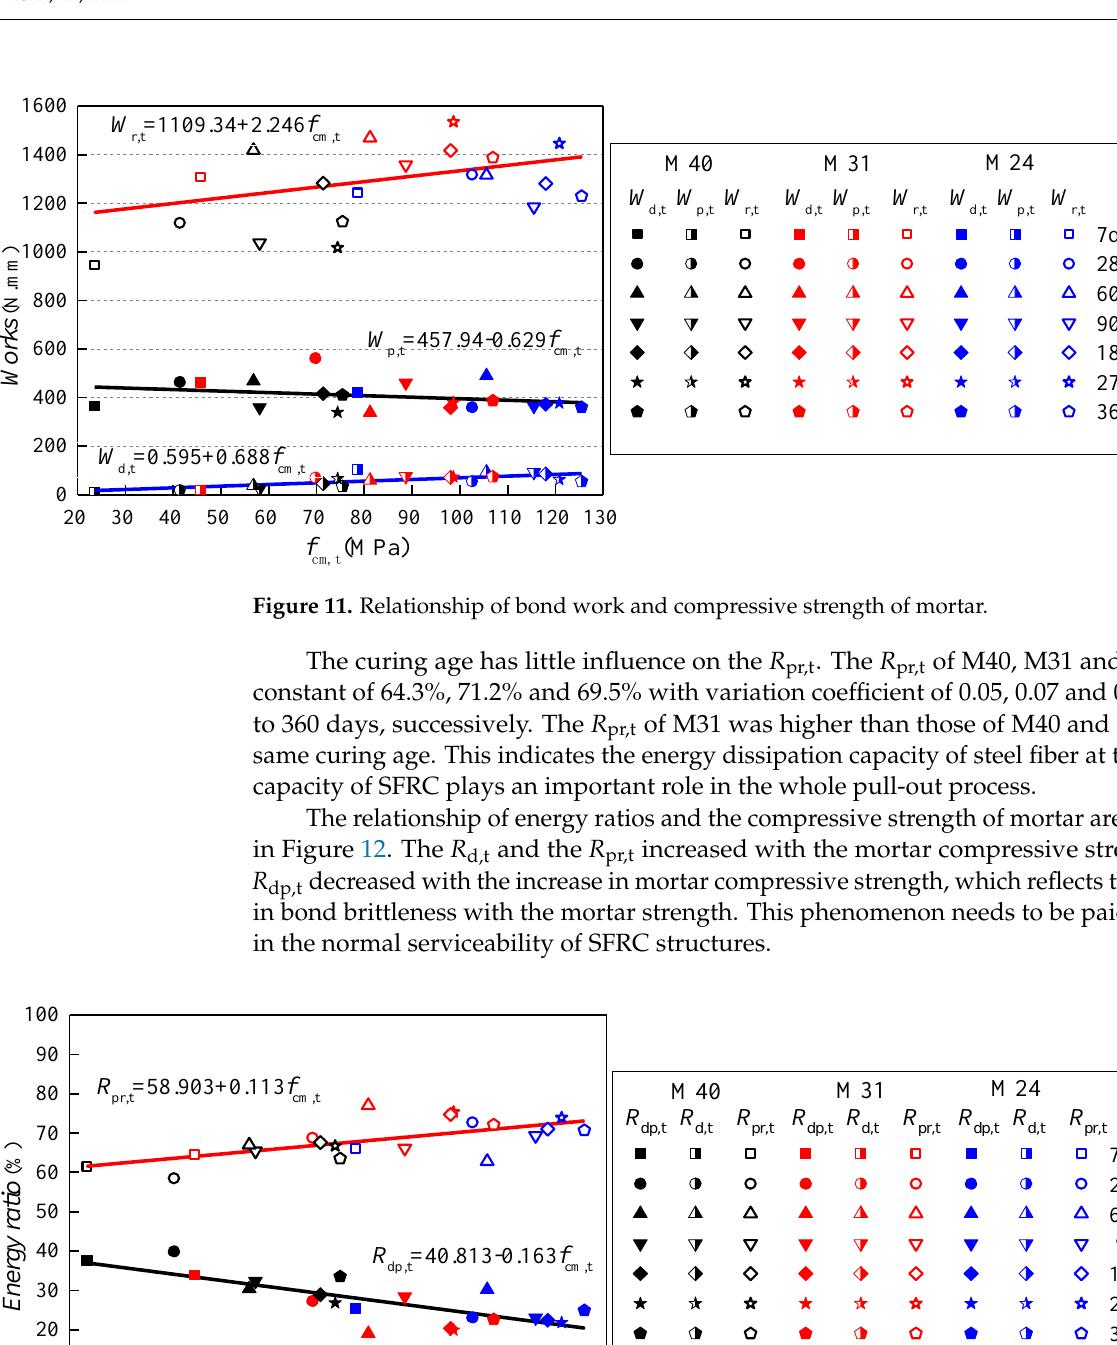
Figure 13. Relationship of bond slips and compressive strength of mortar. 4. Conclusions This paper carried out the pull-out test of hook-end steel fiber embedded in manu- factured sand mortar. Seven curing ages from 7 days to 360 days, and three water to binder ratios of mortar at 0.24, 0.31 and 0.40 were considered as the main factors. The pull- out load vs bond-slip curves were measured and treated to be a characteristic curve for a trial of tests. The values of load and slip at three key points at the characteristic pull-out load-slip curve are extracted. The bond strength, bond energy and bond toughness are analyzed and discussed based on the multi-index synthetical evaluation method. The con- clusions can be drawn as follows: